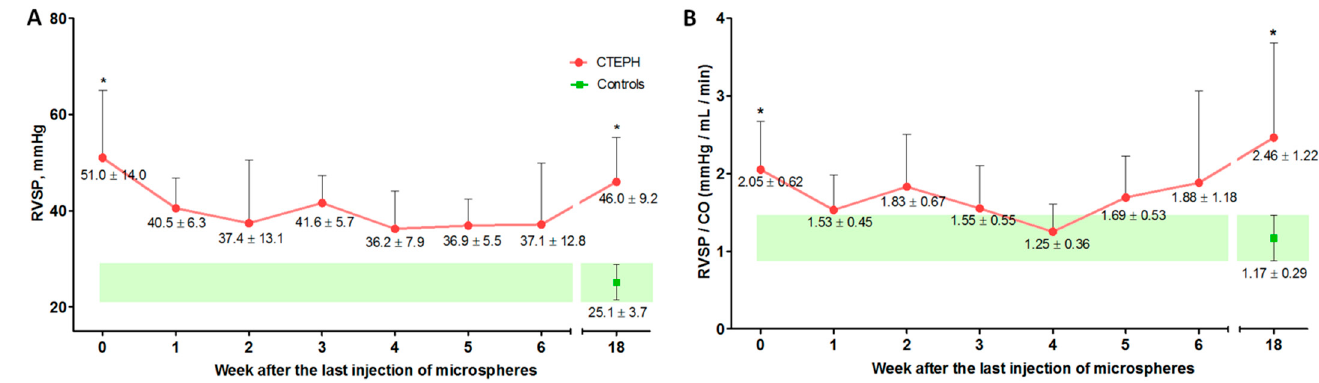
Figure 2. Dynamics of changes in right ventricular systolic pressure (RVSP) ( A ) and RVSP/cardiac output (CO) ratio ( B ) at different times after embolization. * p < 0.05 in comparison with the control group. n = 7 at each time point in CTEPH group.